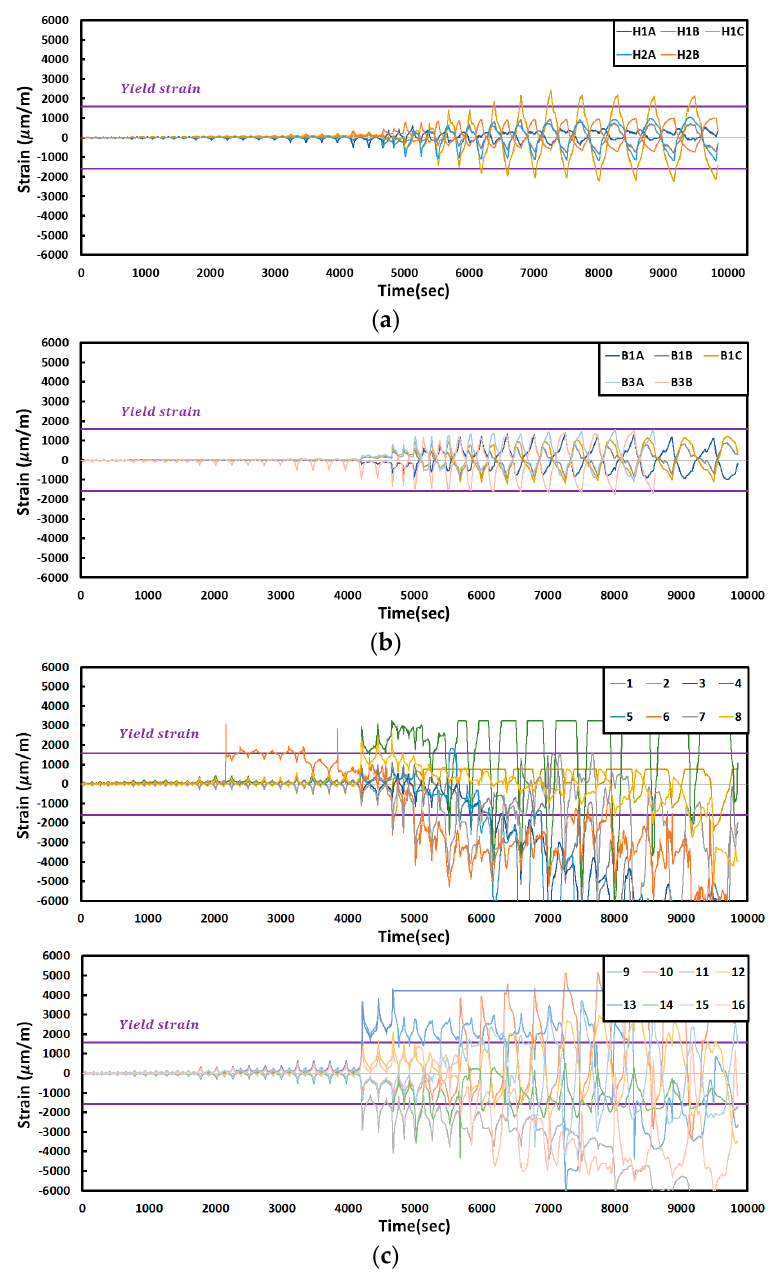
Figure 12. Strain curves of the specimens (FR-TR-H): ( a ) column; ( b ) beam; ( c ) plate.